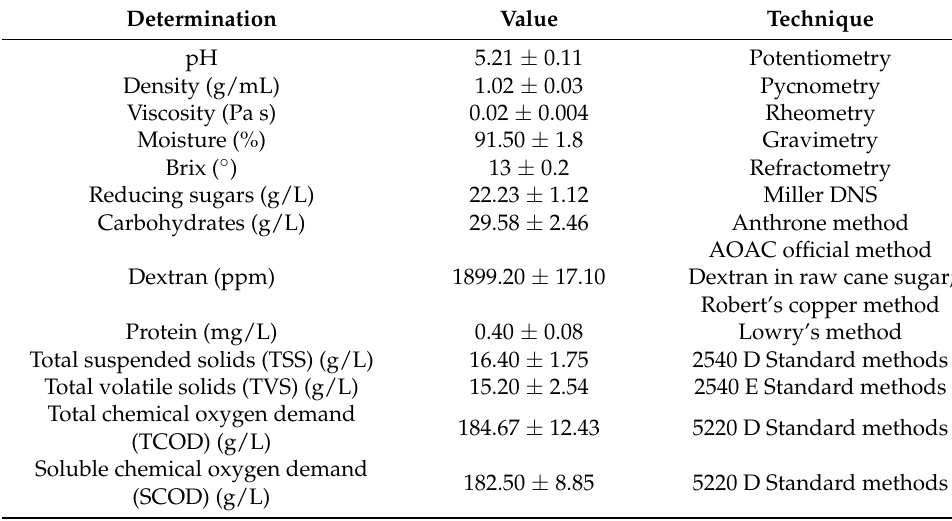
Table 2. Physicochemical characterization of fermented mash.